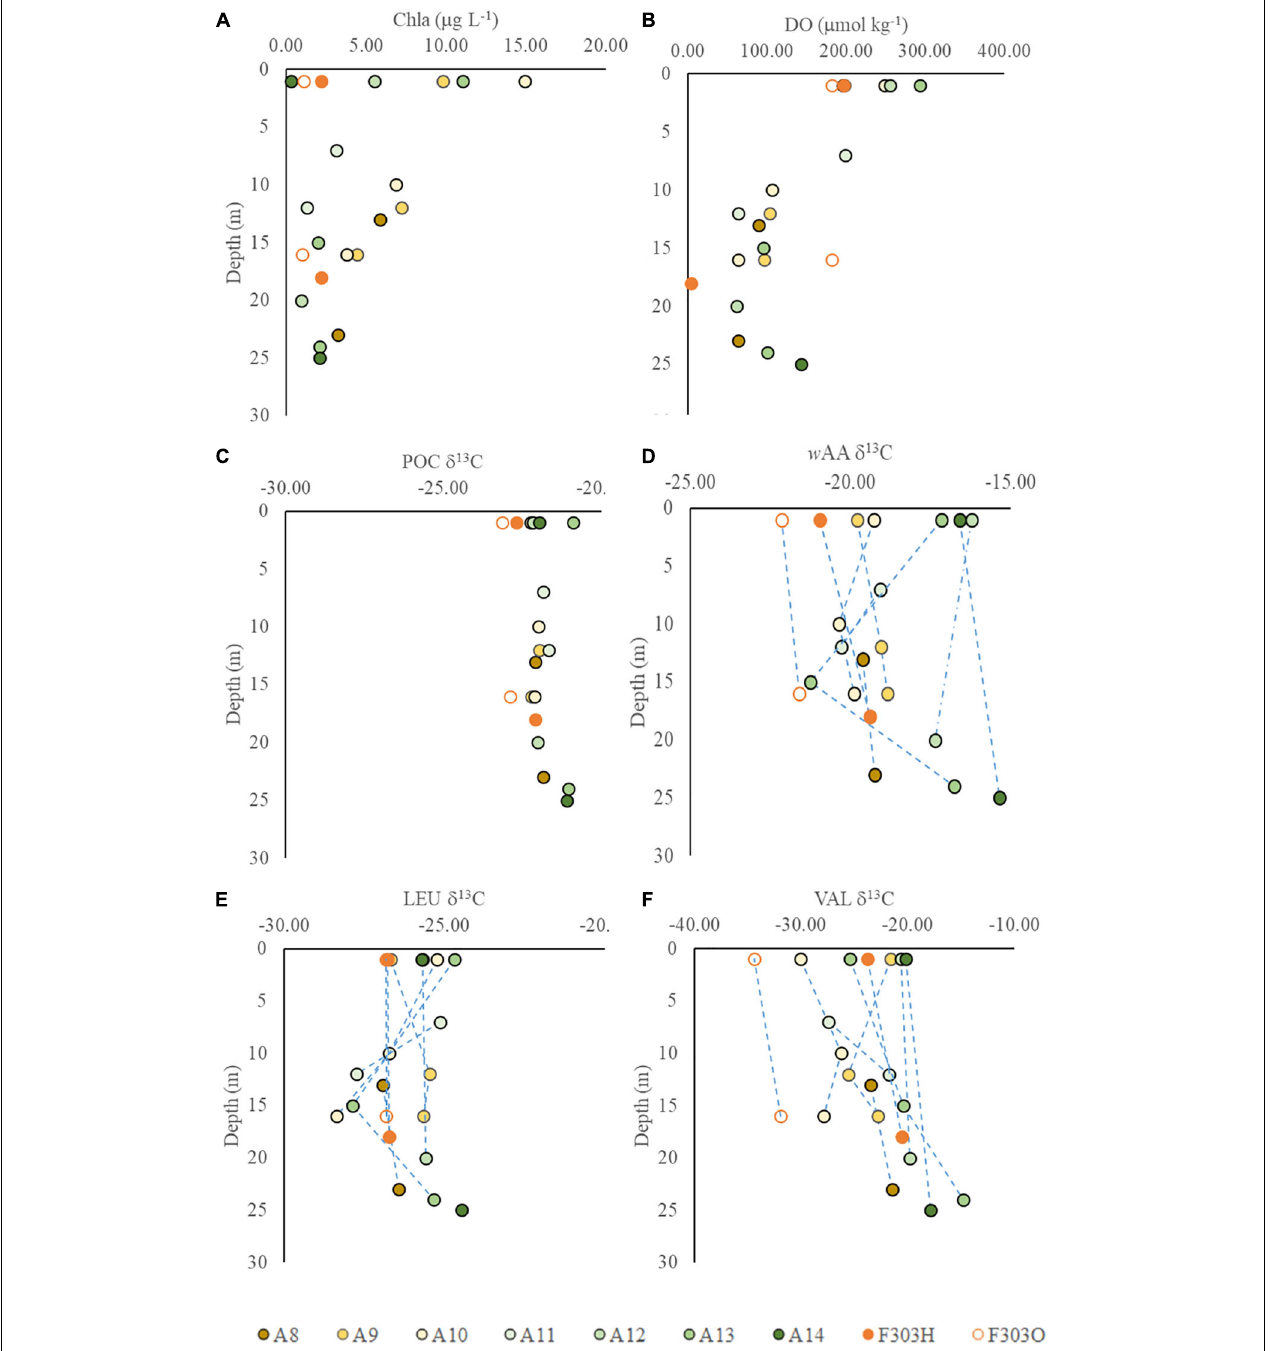
FIGURE 4 | Vertical profiles of δ 13 C values in particles from transect A and station F303 on the NSCS shelf: (A) Chl a ; (B) DO concentrations; (C) particulate organic carbon δ 13 C, PO 13 C; (D) carbon-weighted mean of amino acid δ 13 C, w AA δ 13 C; (E) leucine δ 13 C; and (F) valine δ 13 C. Station F303H and F303O are the two visits to station F303 before and after Tropical Storm Son-Tinh